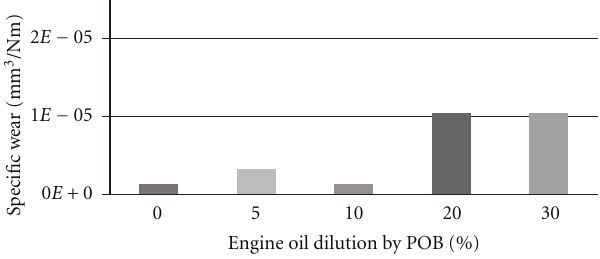
Figure 4: Specific wear for peanut oil biodiesel (POB) diluted engine oil mixtures.